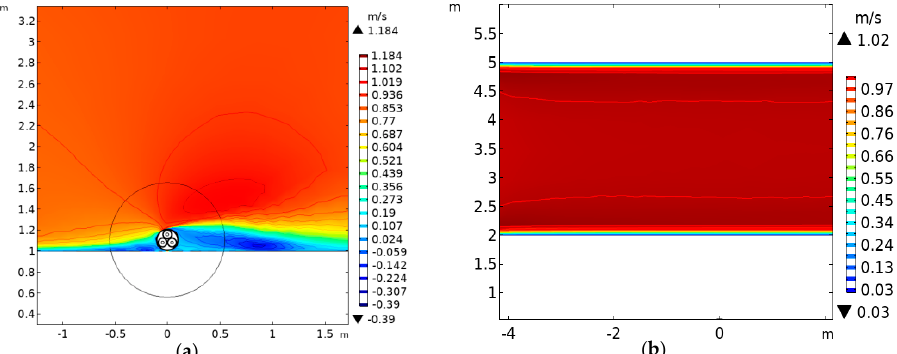
Figure 8. The contour map of seawater velocity distribution. ( a ) The contour map of seawater velocity distribution for sub-sea laying. ( b ) The contour map of seawater velocity distribution for pipe laying and direct burial laying.